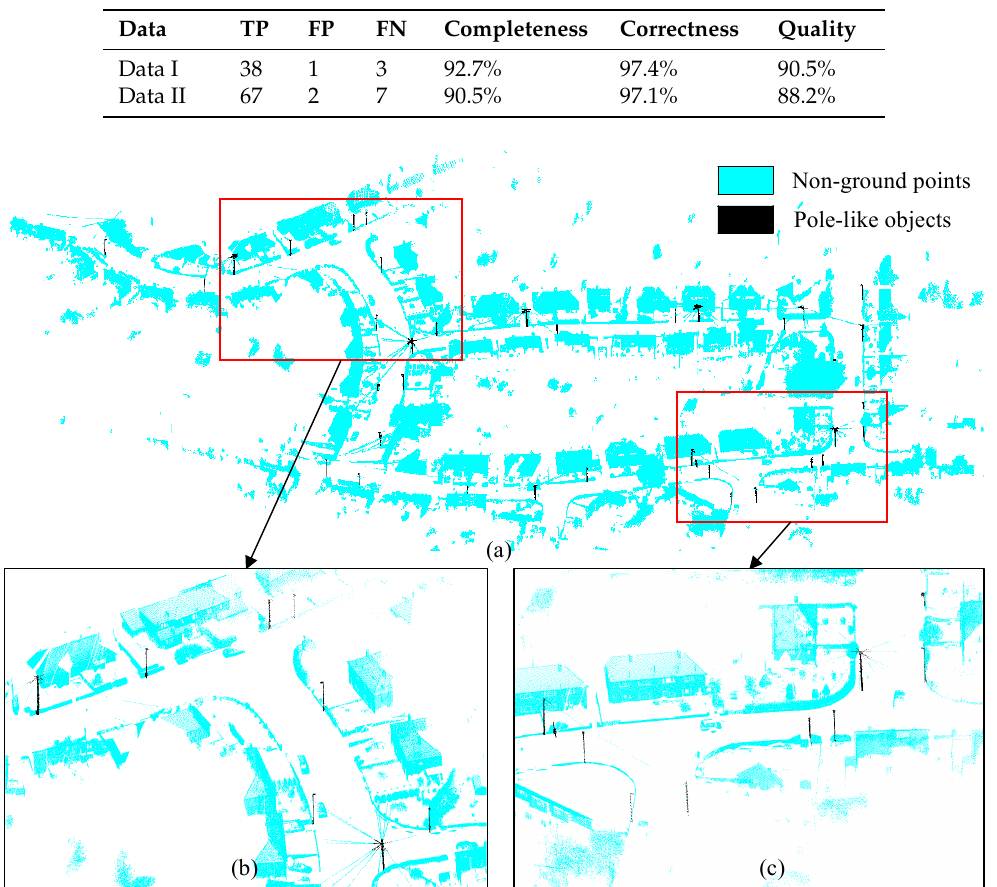
Table 4. PLO extraction quality.